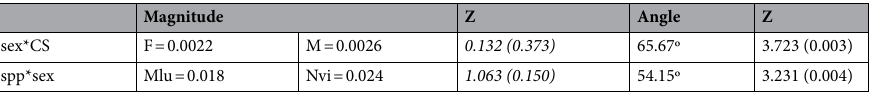
Table 2. Phenotypic trajectory analyses. Results from the trajectory comparison in sexual dimorphism (spp*sex) and sexual allometry (sex*CS) of mandible shape in minks. For each comparison, values of the Z statistic are provided together with its associated p value (in brackets), with non-significant p value in italics. Abbreviations as in Table